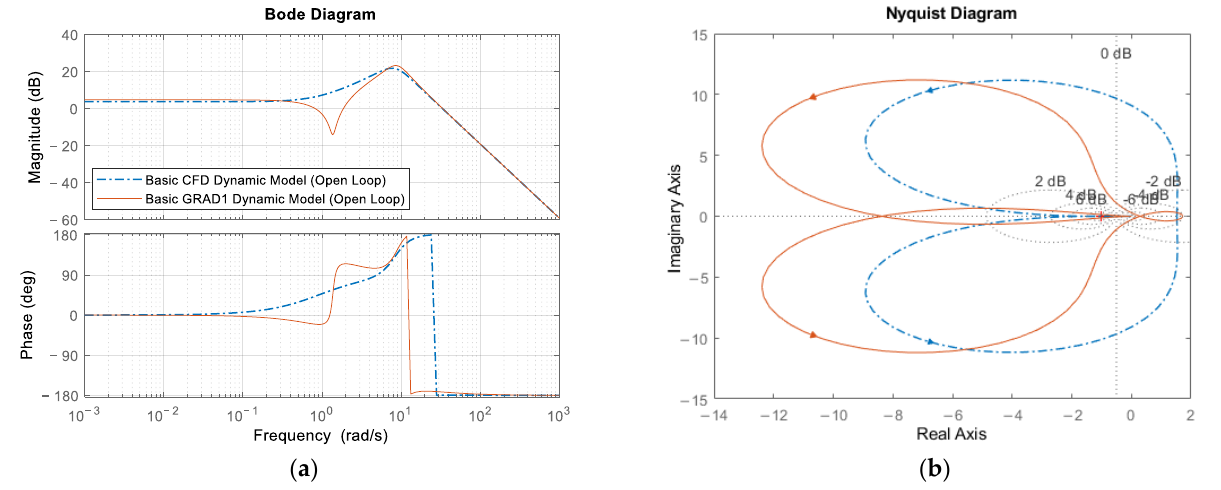
Figure 7. Frequency responses (basic dynamic models only): ( a ) Bode plot; ( b ) Nyquist diagram.